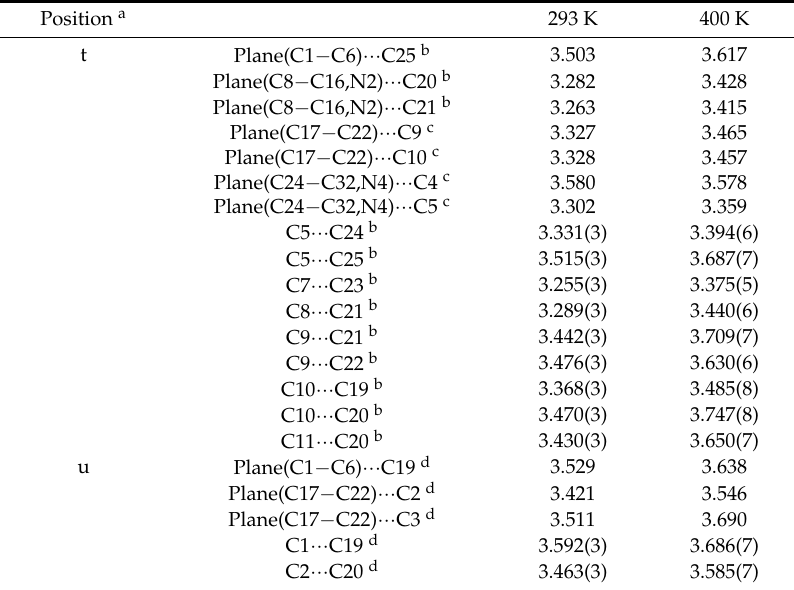
Table 7. Selected intermolecular short distances (Å) in 2 .